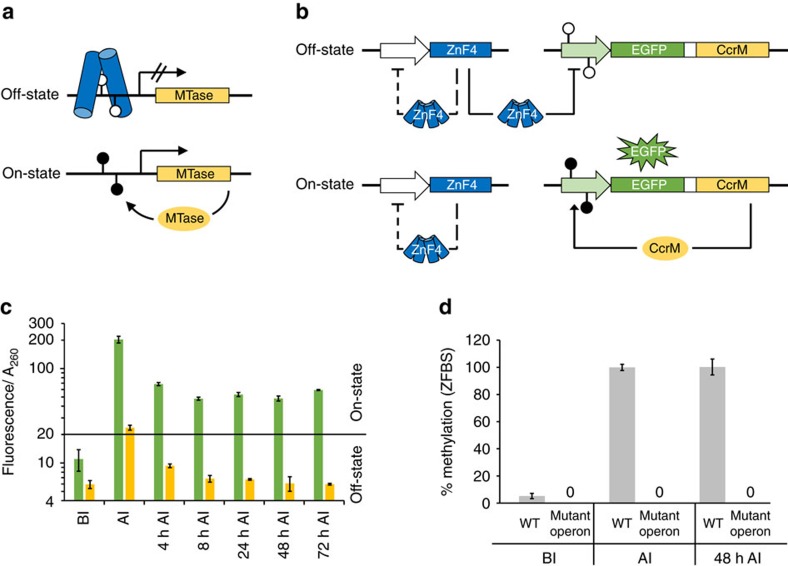
Heat induction of memory system I.(a) Scheme of the synthetic epigenetic memory system I. In the off-state, the synthetic ZnF repressor binds the promoter region of a methyltransferase (MTase) gene. In the on-state, the promoter region is methylated, repressor binding is hindered and the MTase gene is transcribed resulting in a positive feedback loop. Filled and open lollipops represent methylated and unmethylated GANTC sites. (b) Circuit design of the synthetic epigenetic memory system with ZnF repressor and reporter–maintenance operon. In the off-state, ZnF4 inhibits transcription of the reporter-maintenance operon containing EGFP and CcrM. Once the system is switched to the on-state, EGFP and CcrM are expressed and the binding of the ZnF repressor is prevented by DNA methylation. CcrM constantly re-methylates the operator ZnF binding sites and keeps the system in the on-state. The ZnF repressor regulates its own expression in a manner not affected by methylation (indicated by negative feedback with dashed lines). (c) Fluorescence data of XL1-Blue cells transformed with the memory plasmid with reporter–maintenance operon. Cells were cultivated at 30 °C in the off-state (BI, before induction) followed by overnight induction at 37 °C (AI, after induction). Further cultivation of the cells was done at 30 °C and fluorescence measured 4–72 h after switching back to 30 °C (green bars). Orange bars represent the control experiment with a mutant reporter–maintenance operon containing a catalytically inactive CcrM variant (error bars indicate s.d., n=3 biological repeats). The vertical line separates the signal ranges characteristic for the on- and off-state. (d) Restriction-protection-qPCR analysis of promoter methylation of the reporter-maintenance operon (see Supplementary Fig. 12 for details of the assay). For the reporter-maintenance operon with active CcrM (WT), the operator was unmethylated in the off-state (BI). The operator was methylated after heat induction and methylation was maintained for at least 48 h. The operator of the control CcrM mutant reporter–maintenance operon was unmethylated throughout the experiment (error bars indicate s.d., n=3 biological repeats). BI: before induction, AI: after overnight induction by cultivation at 37 °C, AI 48 h: after overnight induction and 48 h cultivation at 30 °C. For statistics, see Supplementary Table 1.